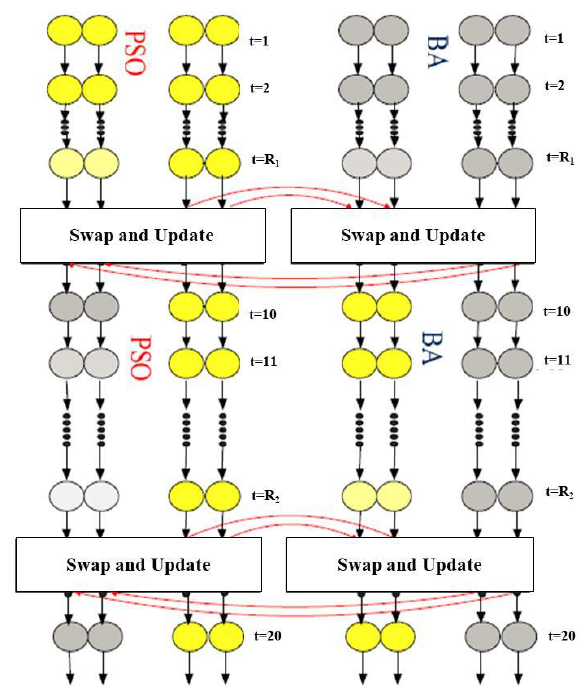
Figure 2. Hybrid algorithm procedure.